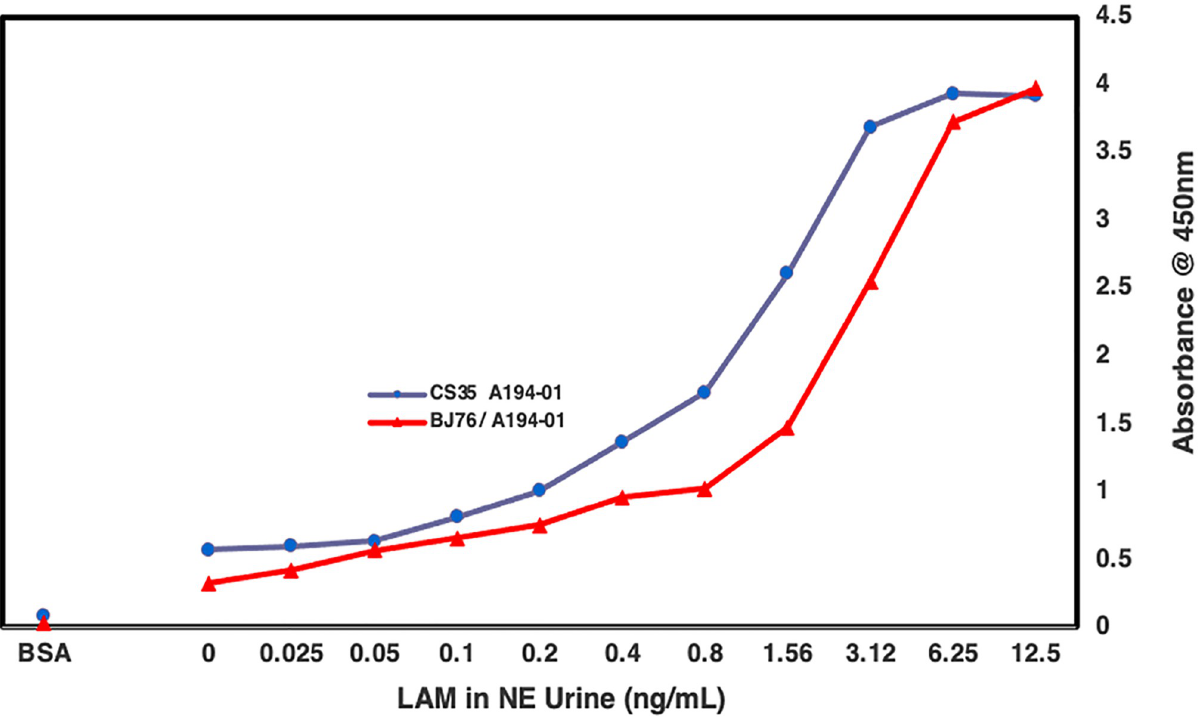
Fig 2. Comparative ELISA OD 450 for two mAbs used for preselection in spiked urine samples. Generation of LAM standard curve with Mtb CDC1551 LAM spiked into urine from a healthy volunteer using C-ELISA showing CS35, mouse mAb @ 10 μ g/mL as capture antibody against biotinylated A194-01, human mAb @ 250ng/mL used as the detection antibody (blue circles) in comparison to BJ76, rabbit mAb @ 2.5 μ g/mL as capture against biotinylated A194-01 @ 250ng/mL as the detection antibody (red triangles). The graph shows BJ76 when paired with A194-01 antibody shows reduction in background signal and improved LoD (from 100pg/mL for CS35/A194-01 pair) to about 50-20pg/mL.